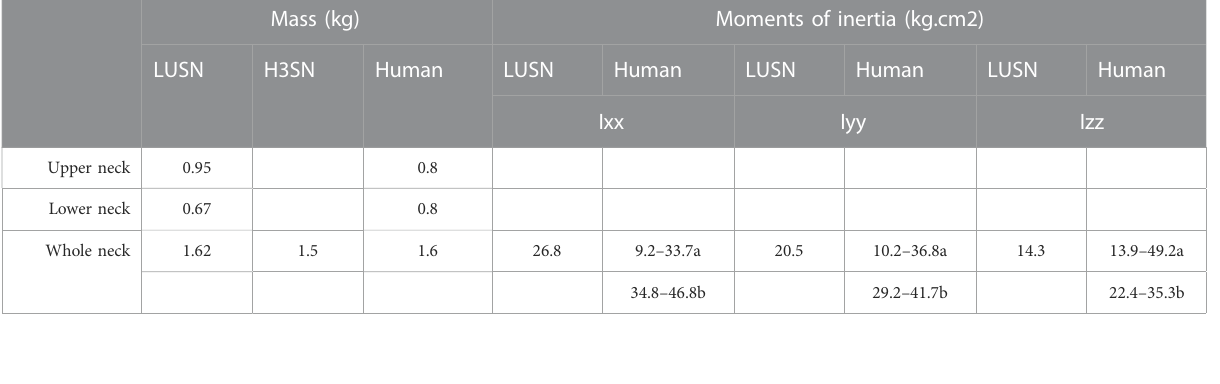
TABLE 5 Comparative (whole and distributed) mass and (whole) moments of inertia of the LUSN, H3SN and human neck a McConville and Churchill (1980), b Kang et al. (2016).